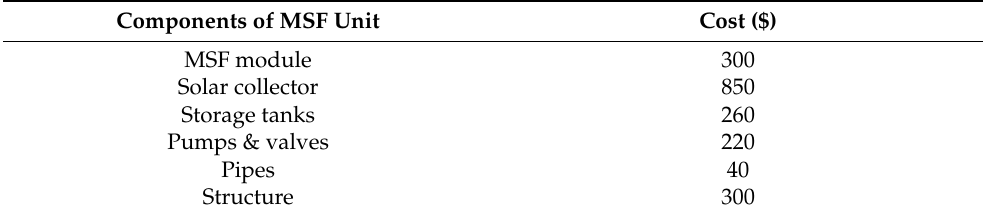
Table 4. Investment cost of components of the